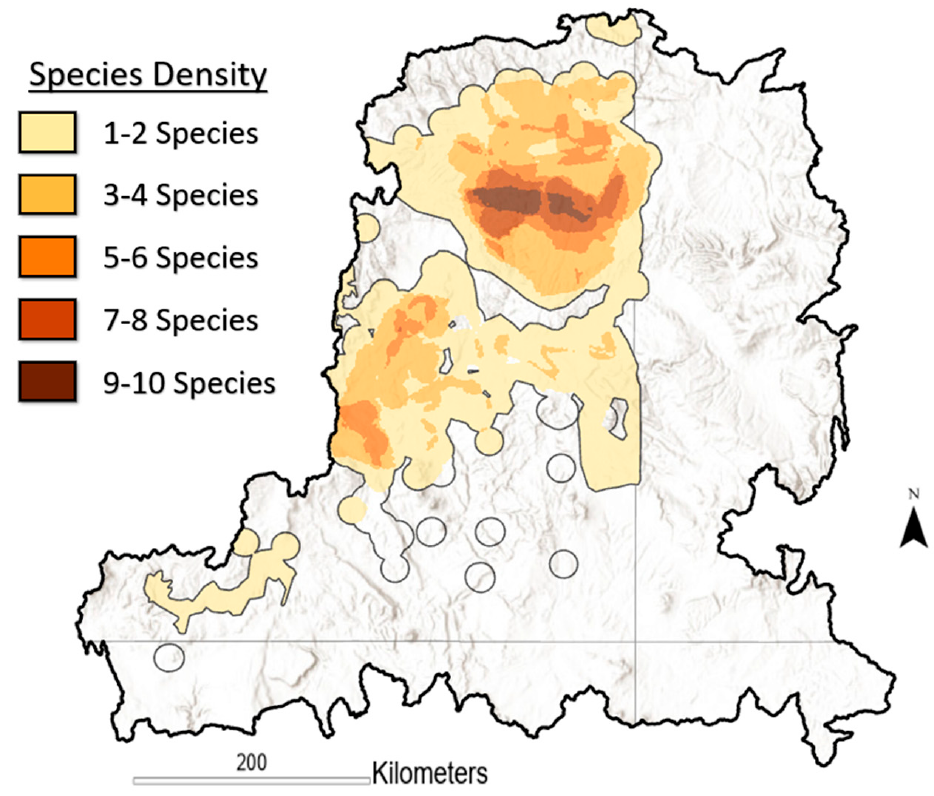
Figure 3. Species distribution modeling output density classifications derived from the number of individual species suitable habitat predicted in each cell.